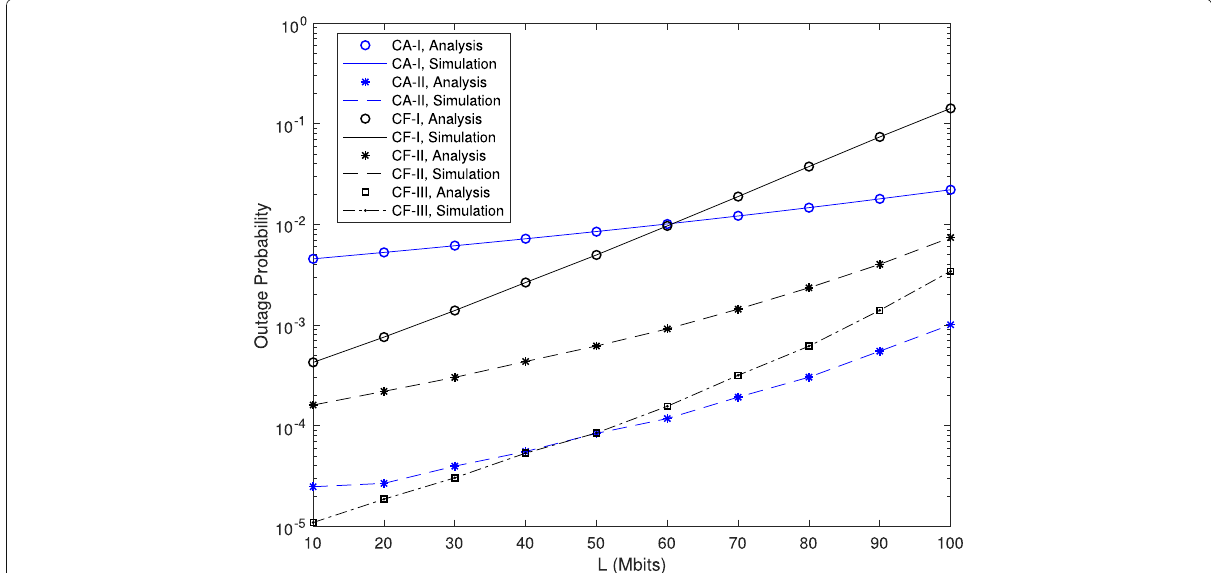
Fig. 4 Outage probability versus L when N = 2, K = 10, B = 100MHz, P /σ 2 = 15dB and T =